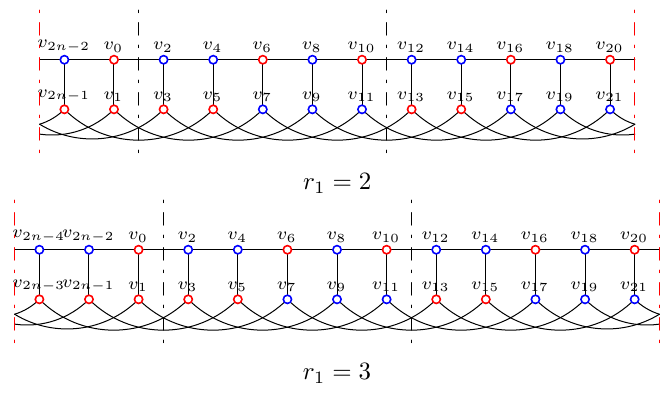
Figure 13. Segments of f in Case 2.1.2 in Lemma 8.